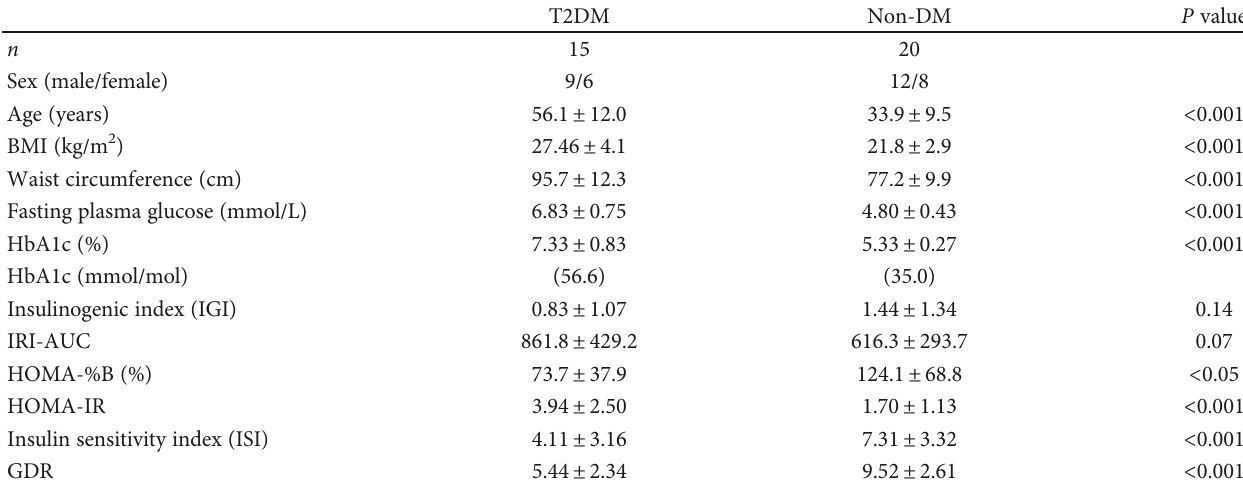
Table 1: Participant